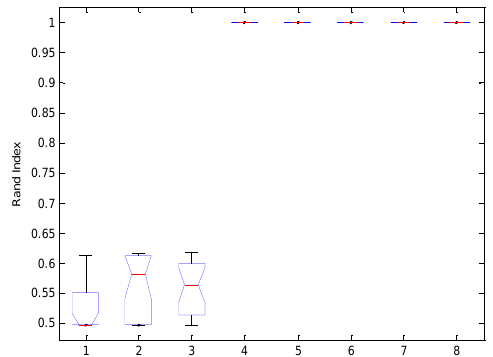
Figure 4. Clustering results of different algorithms for XOR dataset. Eight algorithms (numbered in Section 4.1) are as follow: (1) Euclidean, (2) RCA, (3) Xing’s, (4) kernel-  , (5) unweighted- S , (6) unweighted- SD , (7) augmented- S , and (8) augmented- SD